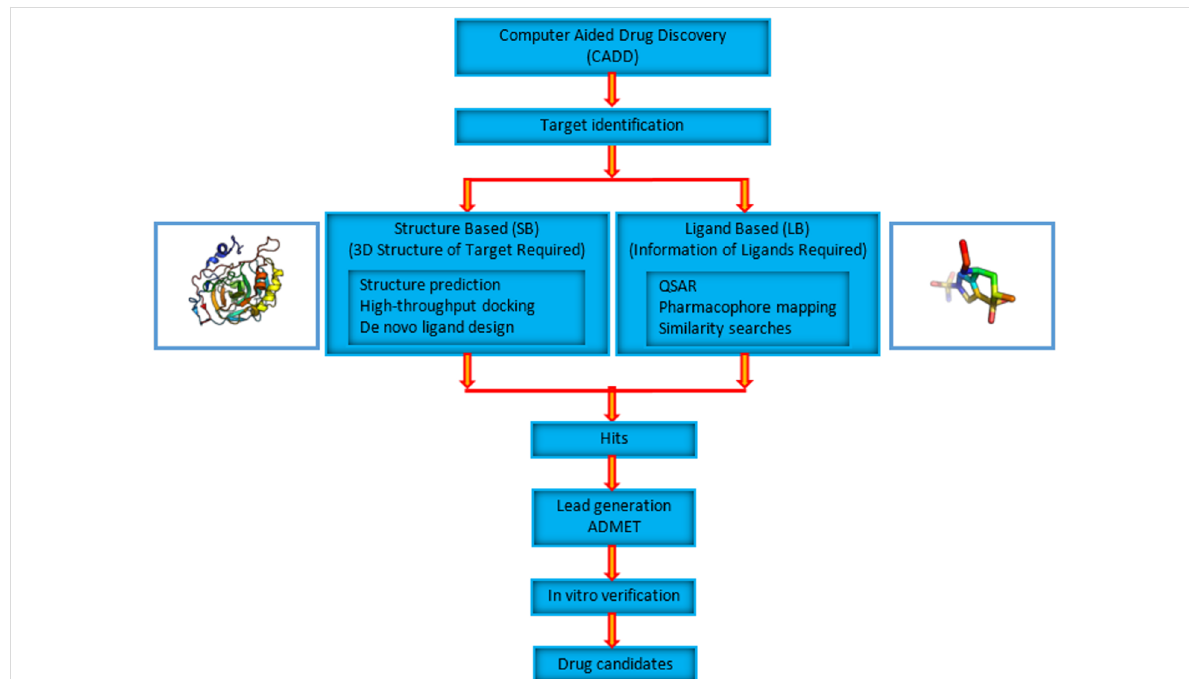
Figure 1: Schematic representation of a computer-aided drug discovery (CADD) pipeline. CADD methods are broadly classified into structure-based and ligand-based methods. Structure-based methods require the 3D information of the target to be known. Ligand-based methods are used when the 3D structure of the target is not known. They use information about the molecules that bind to the target of interest. Hits are identified, filtered and op- timized to obtain potential drug candidates that will be experimentally tested in